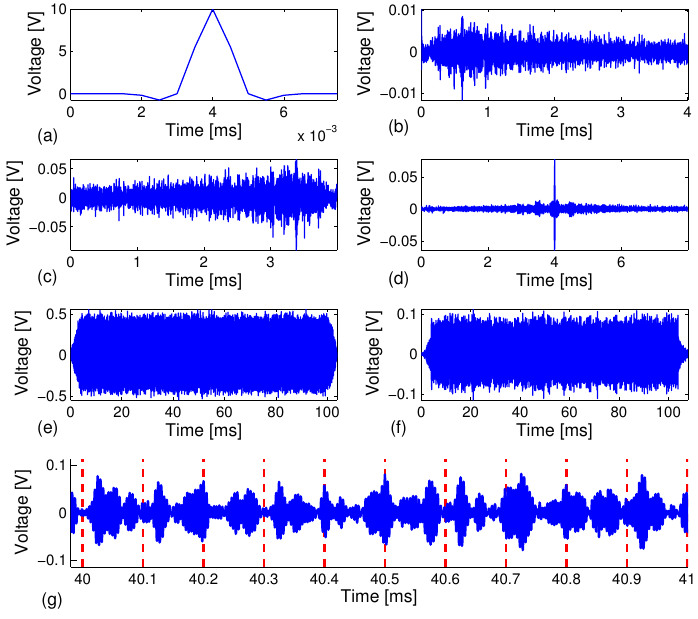
Snapshots of waveforms obtained experimentally from TR-PPM